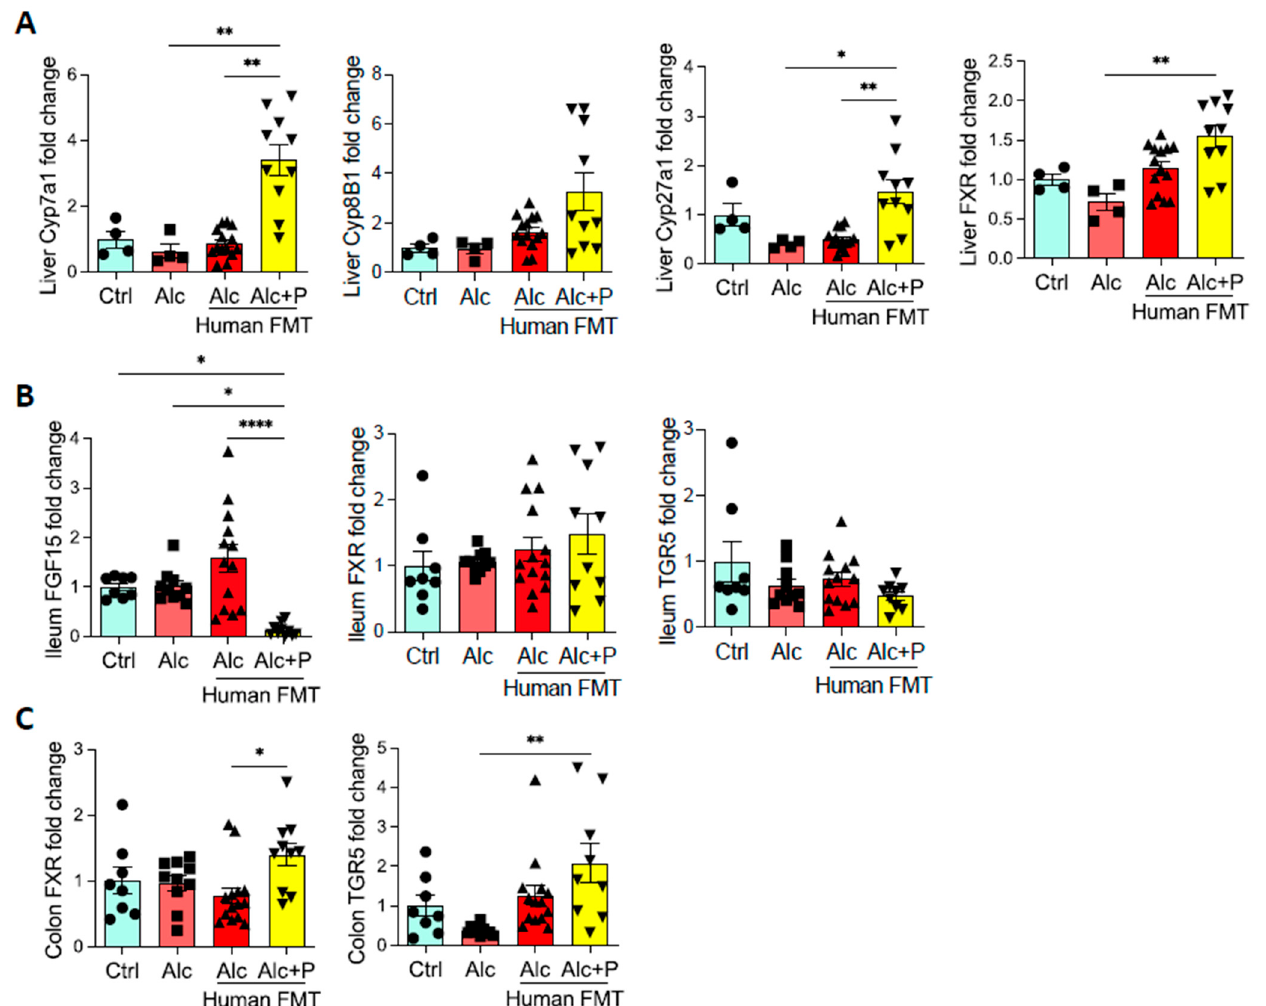
Figure 7. Bile acid (BA) signaling. Control (Ctrl) and alcohol-fed (Alc) mice received a Lieber DeCarli diet with isocaloric maltodextrin or alcohol, respectively. Pectin-treated mice (Alc + p ) received 6.5% pectin in addition to 5% ethanol. Human fecal microbiota transfer (FMT) groups received the microbiota of a patient with alcoholic hepatitis. Quantification of the mRNA levels of enzymes involved in liver BA synthesis (Cholesterol 7 alpha-hydroxylase, Cyp7a1; Sterol 12-alpha-hydroxylase, Cyp8b1; sterol 27-hydroxylase, Cyp27a1; Farnesoid X receptor, FXR) ( A ), ileal BA signaling (fibroblast growth factor 15, FGF15, FXR, G protein-coupled bile acid receptor 1, TGR5) ( B ), and colon BA signaling (FXR, TGR5) ( C ) by qPCR. * p < 0.05, ** p < 0.01, **** p < 0.0001.